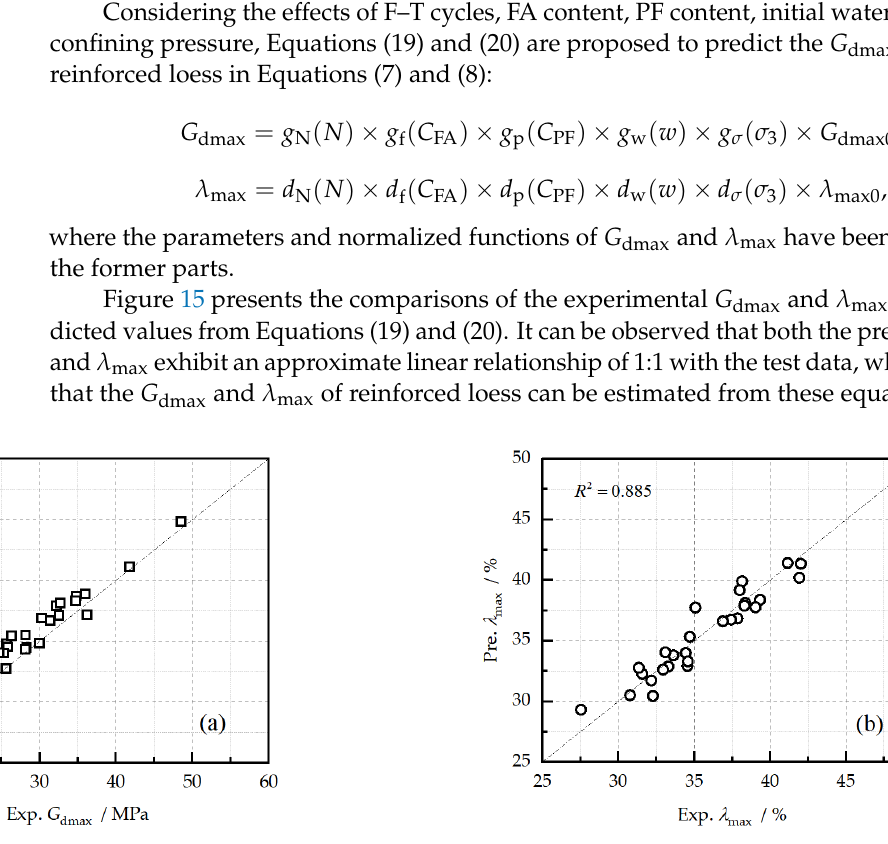
G and λ . Figure 14. Effects of confining pressure on G max dmax dmax and λ max .